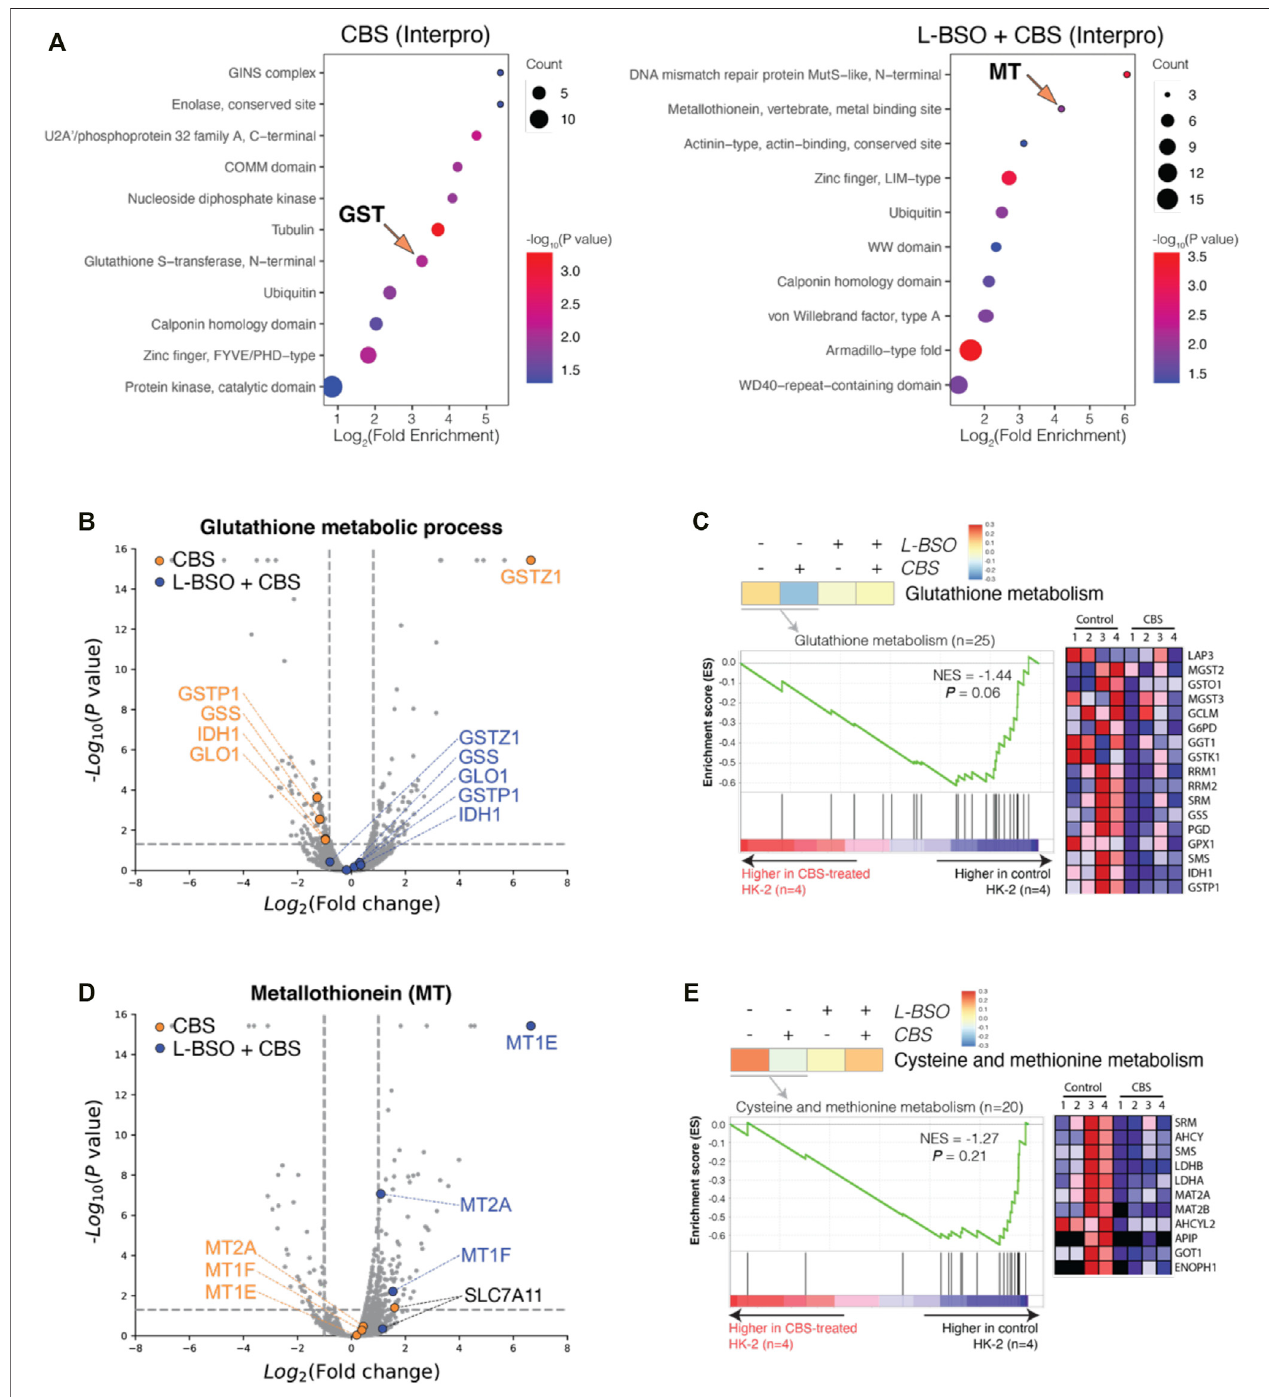
FIGURE 3 | Bismuth induces MT expression only in the absence of GSH. (A) Enrichment analysis of DEPs in normal and GSH-depleted HK-2 cells treated with CBS, in perspective of Interpro. (B) Volcano plots visualizing DEPs of the GO term glutathione metabolic process. (C) GSEA results visualizing the GO term glutathione metabolism. (D) Volcano plots visualizing metallothionein isoforms and cystine importer Slc7a11. (E) GSEA results visualizing the GO term cysteine and methionine metabolism. HK-2 cells were treated with 500 μ M CBS for 48 h or were treated with 500 μ M L-BSO for 24 h to remove GSH and then cultured with 500 μ M CBS for additional 24 h. Bismuth reduces cisplatin-induced apoptosis and enhances GSH metabolism synchronously.